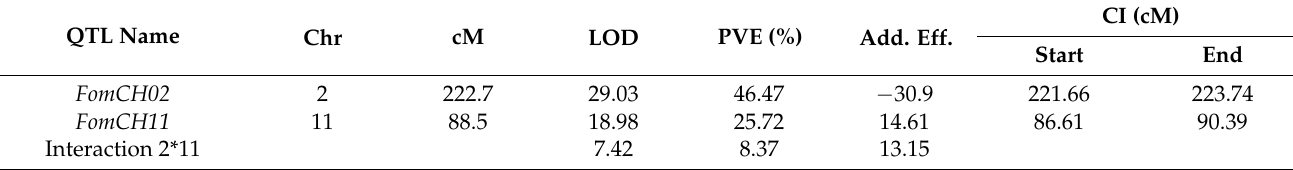
Table 3. QTL identified as associated with Fusarium resistance. Chromosomes (Chr), peak marker position (cM), LOD scores, percentages of phenotypic variance explained (PVE%), estimated additive effects (Add. Eff.), and the confidence intervals (CI) were also provided.